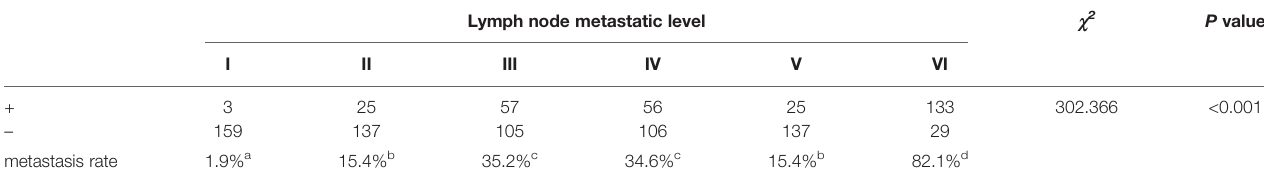
TABLE 6 | Regional status of cervical lymph node metastasis in 162 cases of